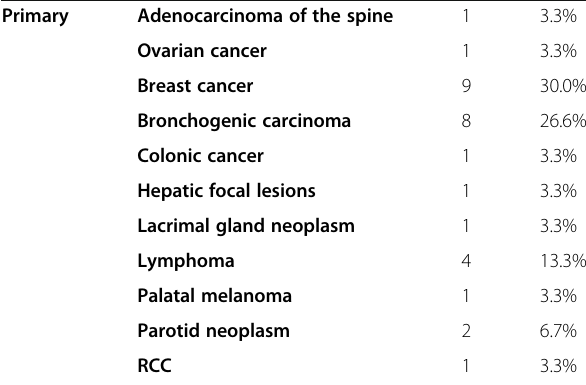
Table 1 CT findings in the 30 patients of study population